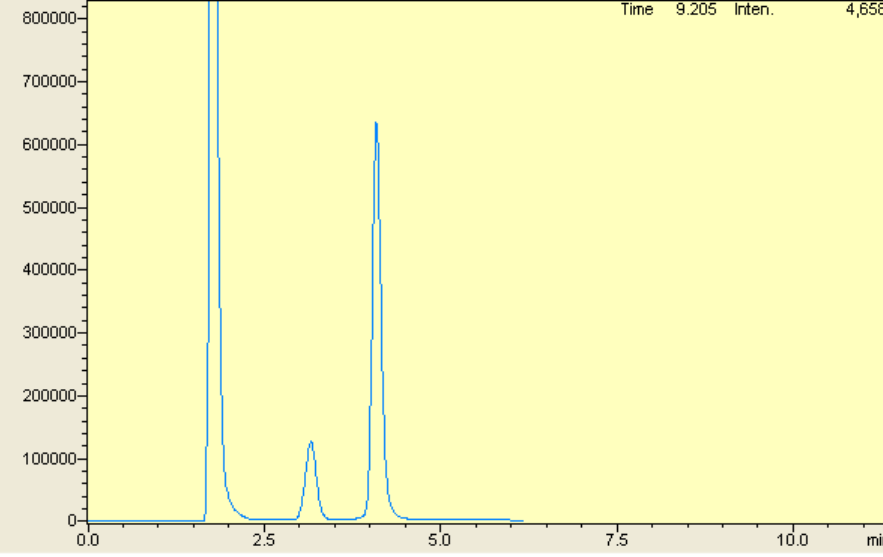
Figure 2. Typical Chromatogram of MOX [1.77 min], VST [3.22 min] and FLX [4.26 min].